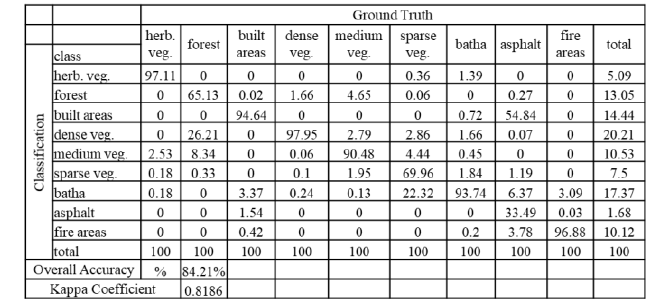
Table 5: Confusion matrix and accuracy measures of SVM coefficients